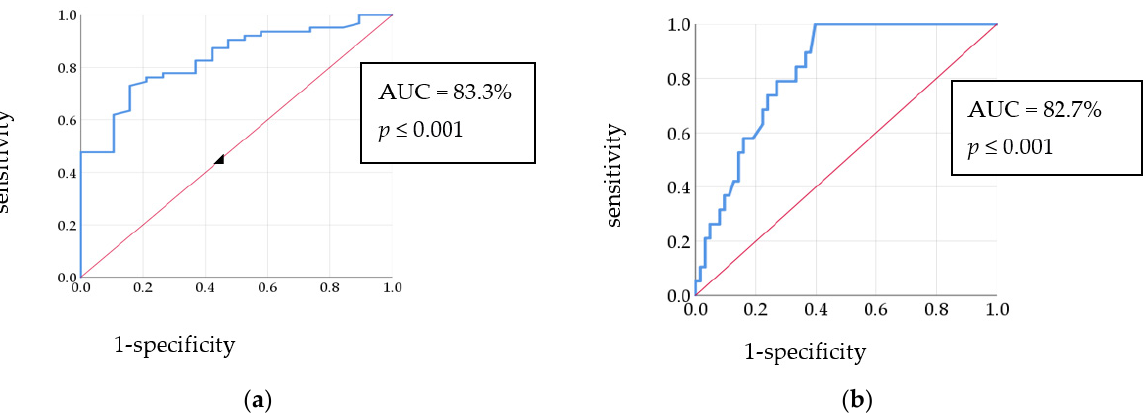
Figure 2. ( a ) ROC curve for the methylation% of MEFV gene exon 2 in FMF patients and control group; ( b ) ROC curve for the pyrin level in FMF patients and control group. The correlation between the mean methylation% of the MEFV exon 2 and that of pyrin concentration was significantly positive in the control group (r = 0.584, p = 0.009 **) and non ‐ significant among FMF patients (r = 0.01, p = 0.938), Figure 3.